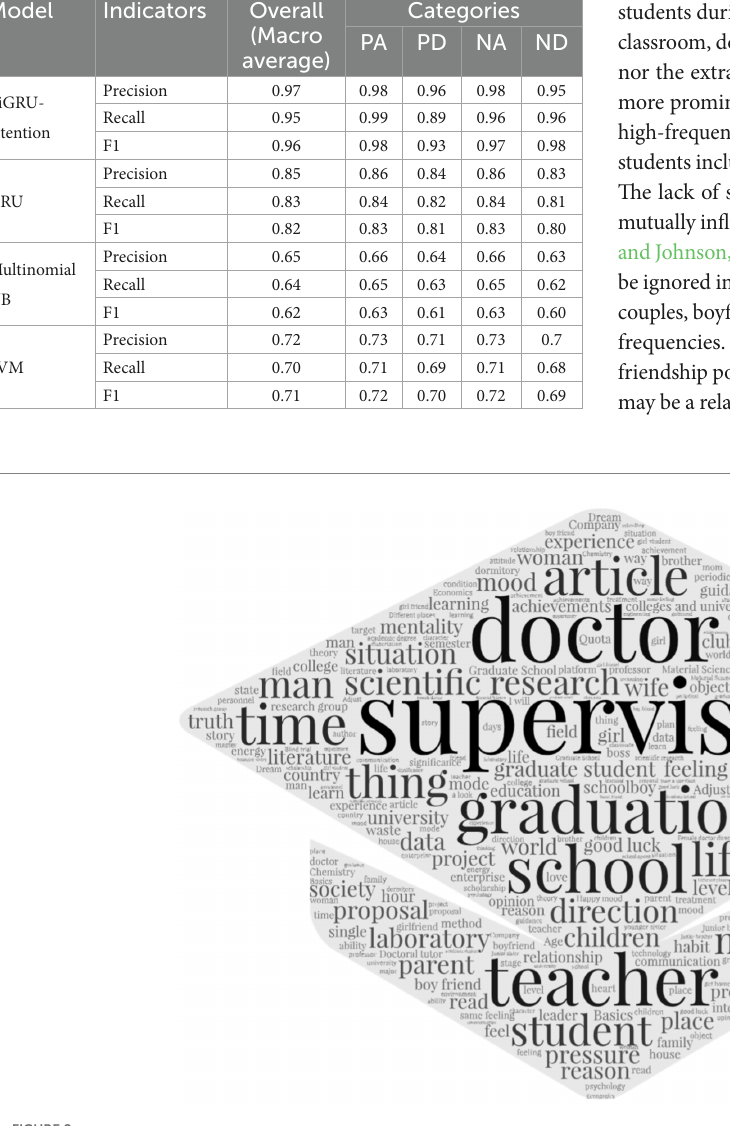
FIGURE 8 High frequency words word cloud. N word_freq > 100,